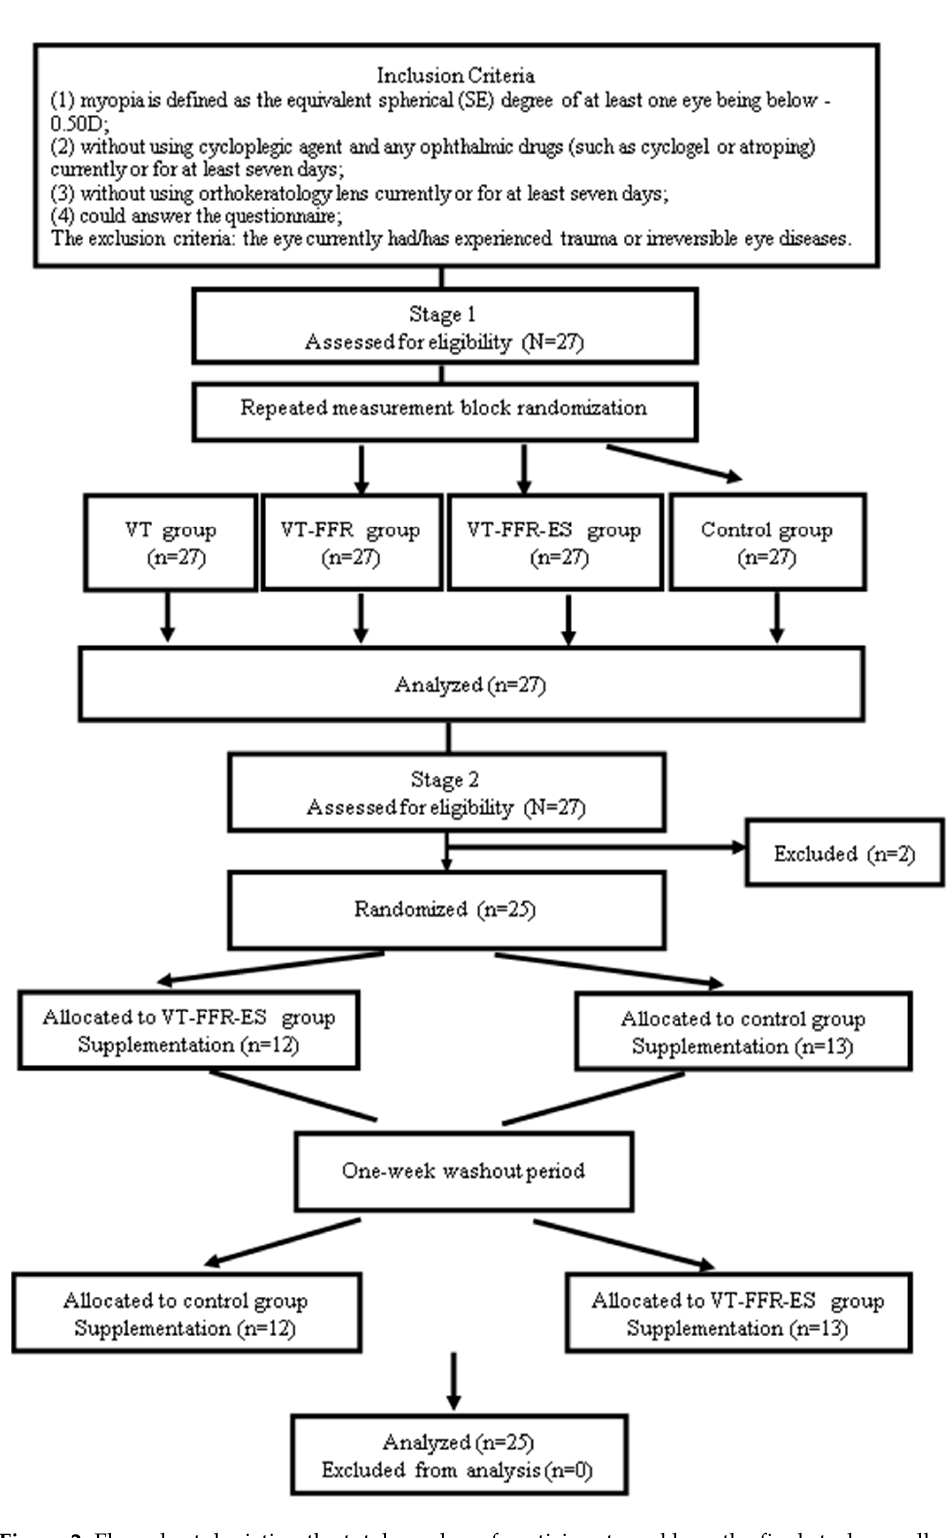
Figure 2. Flow chart depicting the total number of participants and how the final study enrollment was achieved. VT: Vision training; VT-FFR: Vision training and frequency following response; VT-FFR-ES: Vision training, frequency following response and electrical stimulation; Control group: No function group of VT-FFR-ES.